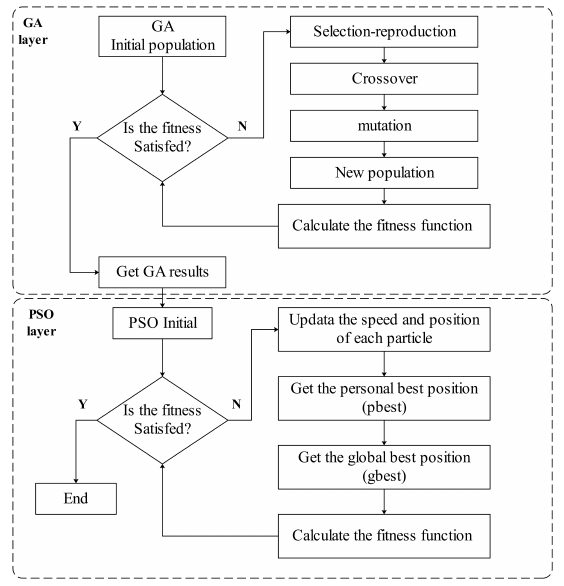
Figure 14. The GA-PSO iterative flow chart. The GA-PSO algorithm was applied to the parameter identification of the FOGF system, and the root-mean-squared (RMS) error was introduced as the fitness function. The minimum RMS value was taken as the objective, and the model was iteratively identified.